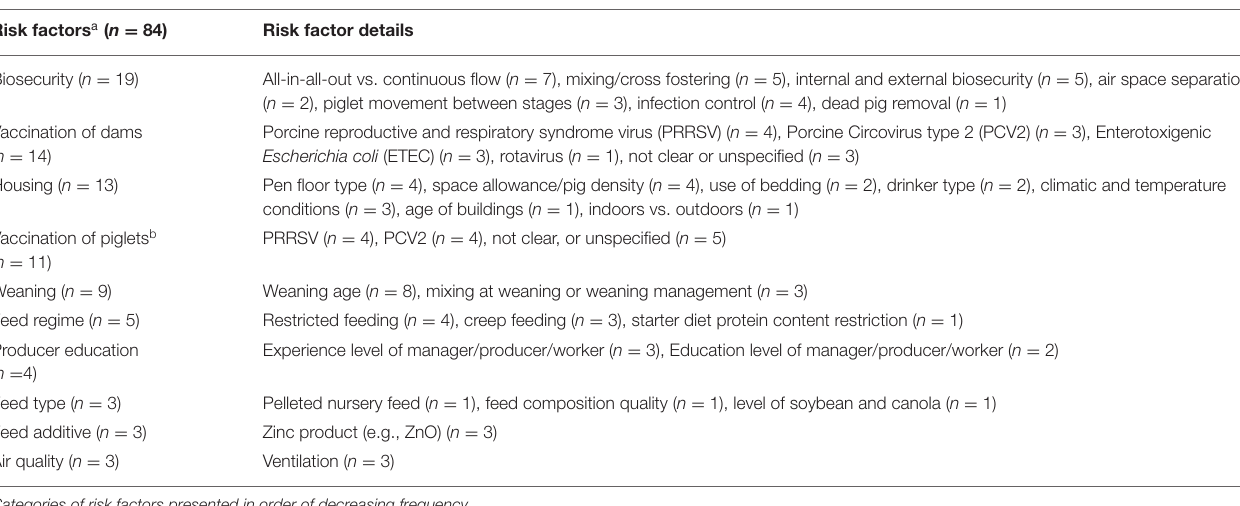
FIGURE 3 | Number of interventions or risk factors ( n = 579) described in clinical trials ( n = 414) and observational studies ( n = 27). TABLE 4 | Risk factors described in observational studies ( n =